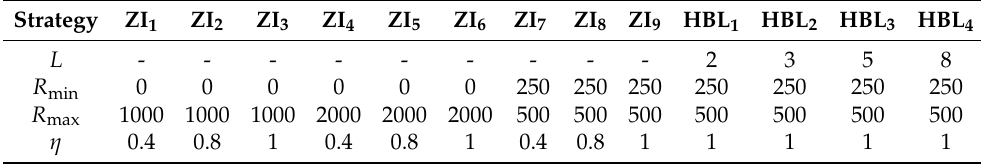
Table A11. Background trading strategies included in EGTA for cloaking mechanisms. Strategy